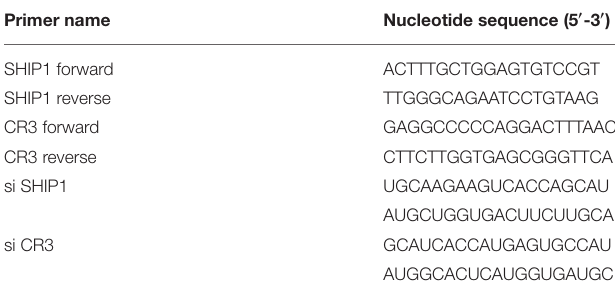
TABLE 1 | Primers used in this